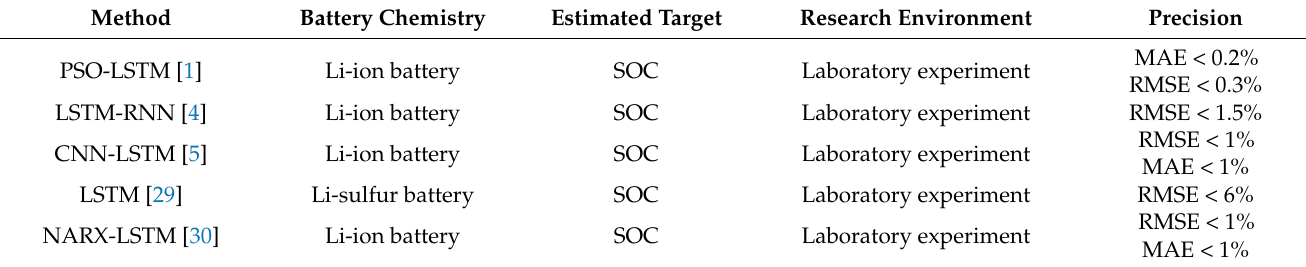
Table 4. Comparison of errors for various studies.